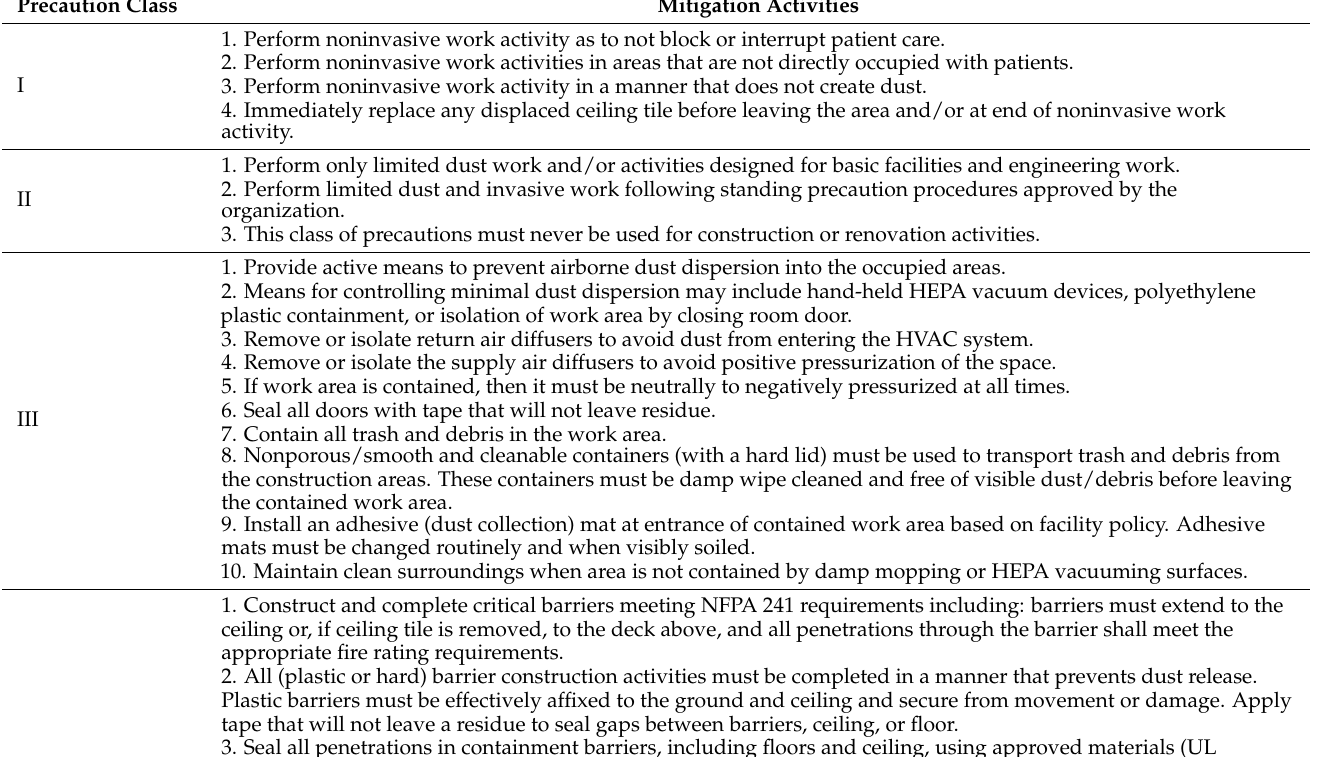
Table 5. Precaution Classes I–V before and during work activity according to Infection Control Risk Assessment (ICRA (2.0). Author’s adaptation of